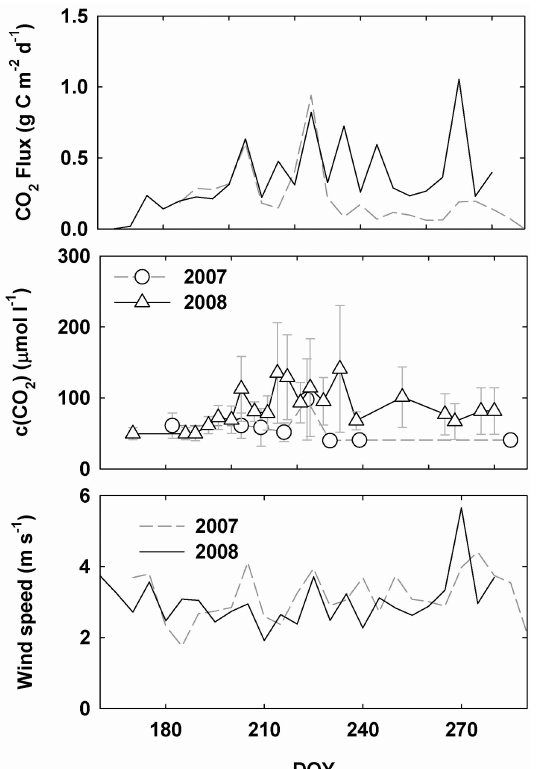
Fig. 7. CO 2 flux in thermokarst lakes during the open water period (top), CO 2 concentration in the surface water (middle) and local wind speed at 2m (bottom) ( n = 3). Flux and wind speed data are 5-day averages, whereas CO 2 concentrations in the surface water are shown for each sampling occasion (mean ± SD).